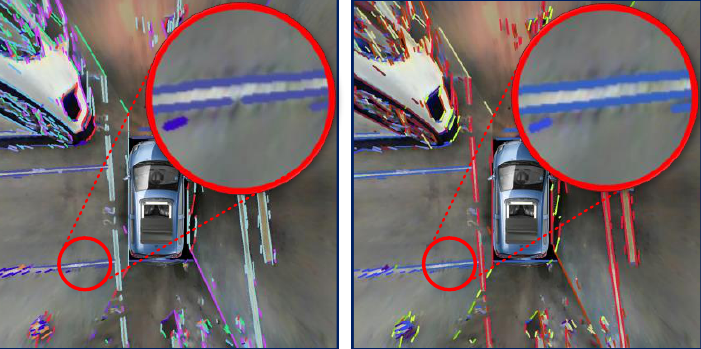
Figure 5. Result of line combination Left : before combination Right : after